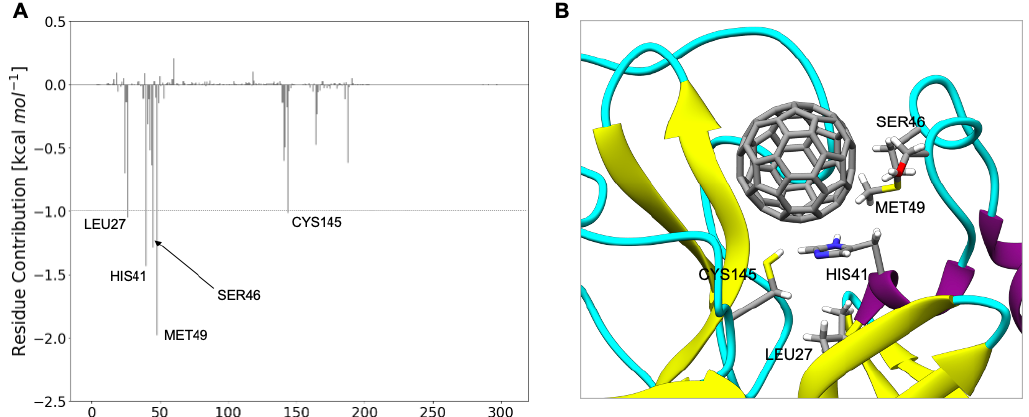
Figure 3. ( A ) C 60 @M pro interactions. Δ G binding decomposed per residue. ( B ) Interaction between Met49, His41, Ser46, Leu27, and Cys145 and C 60 .